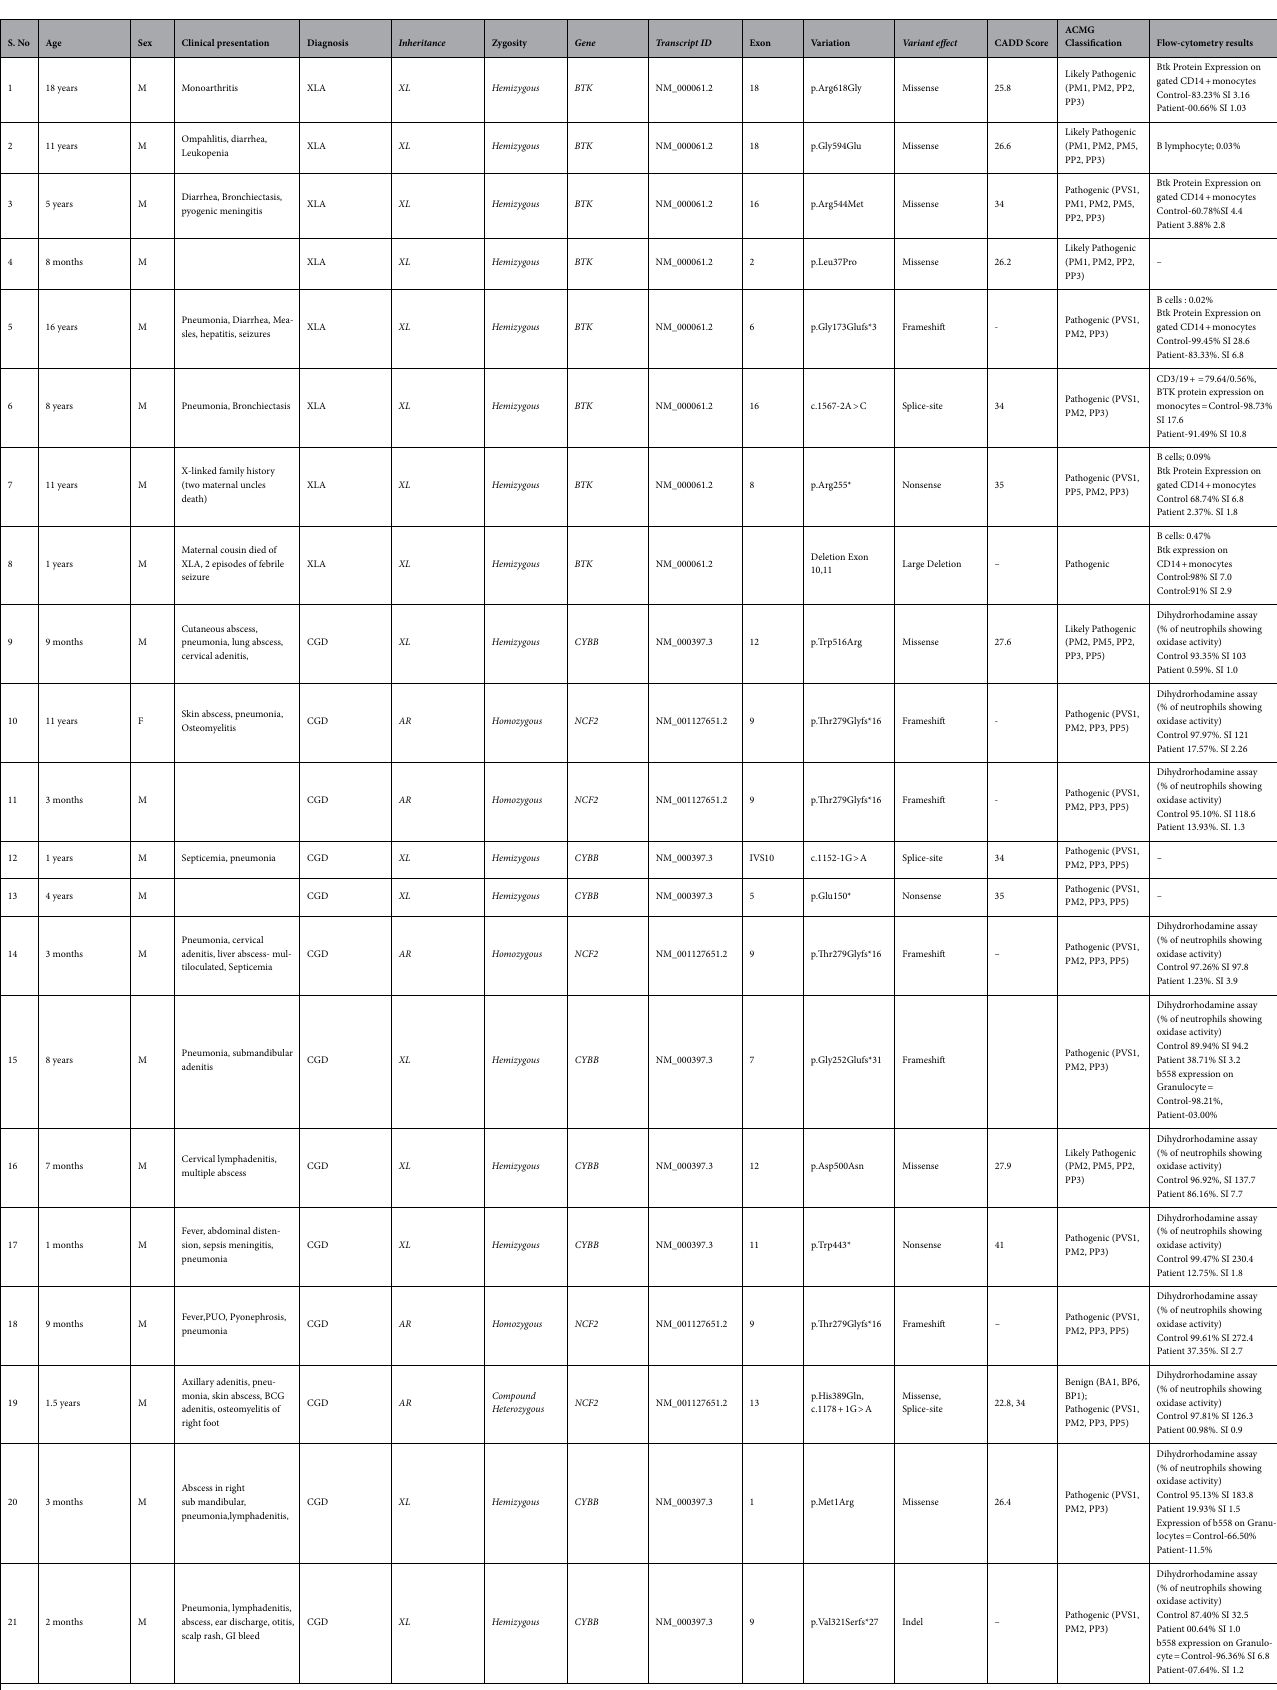
B cells: 0.47% Btk expression on CD14 + monocytes Control:98% SI 7.0 Control:91% SI